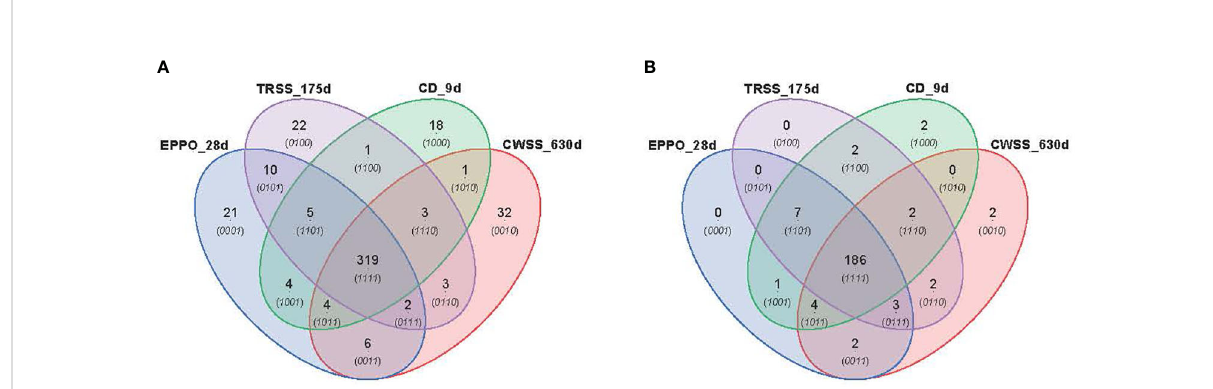
FIGURE 5 Comparison of overall lipid and volatile metabolites at storage time point when seed germination had decreased to around 50% ( P 50 ). (A) Venn diagram showing number of unique and overlapping lipid compounds. (B) Venn diagram for volatile